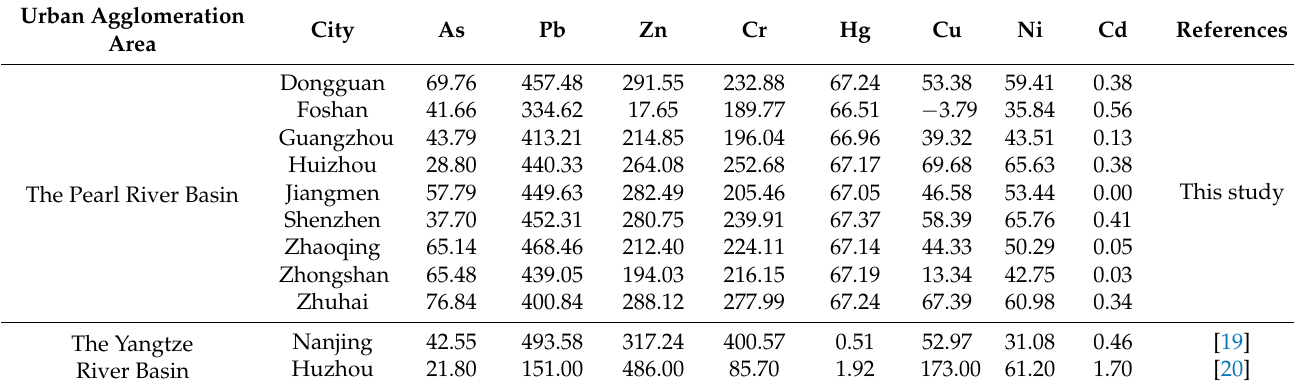
Figure 2. Residual environmental capacity of the heavy metals in the soil of the Pearl River Basin. Table 4. Residual capacity in the soils of the cities in the Pearl River Basin (kg/hm 2